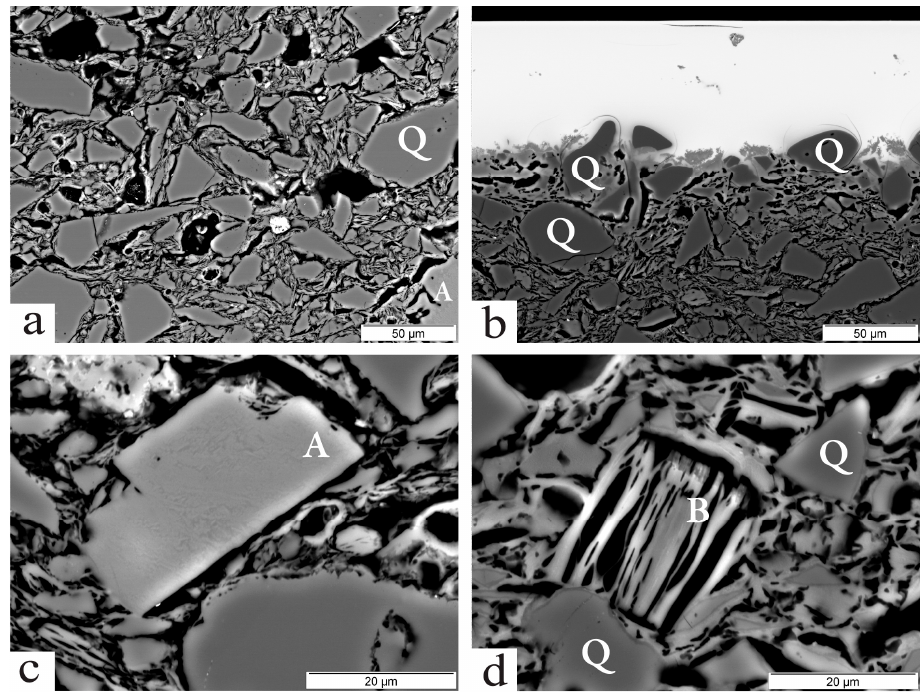
Figure 17. SEM-BSE images of CaO-poor white earthenwares [37]. ( a ) Ceramic body with many angular quartz fragments (Q) in a fine grained matrix. Sample CAR 13. Picolas & Neuenschwander, Carouge, 1880; ( b ) Contact glaze (above)-ceramic body (below) with obvious signs of quartz and matrix resorption by the liquid glaze during firing. CAR 16, Coppier & C ie , Carouge, 1904–1916; ( c ) Rectangular and sharp-edged type A grain, filled with microcrystals of lighter color, most likely mullite. CAR 11, Clément Coppier, Carouge, 1910–1928; ( d ) Type B grain with phyllosilicate appearance typical of a kaolinite cut parallel to the c-axis. CAR 15, Charles Degrange & C ie , Carouge, 1885–1903.